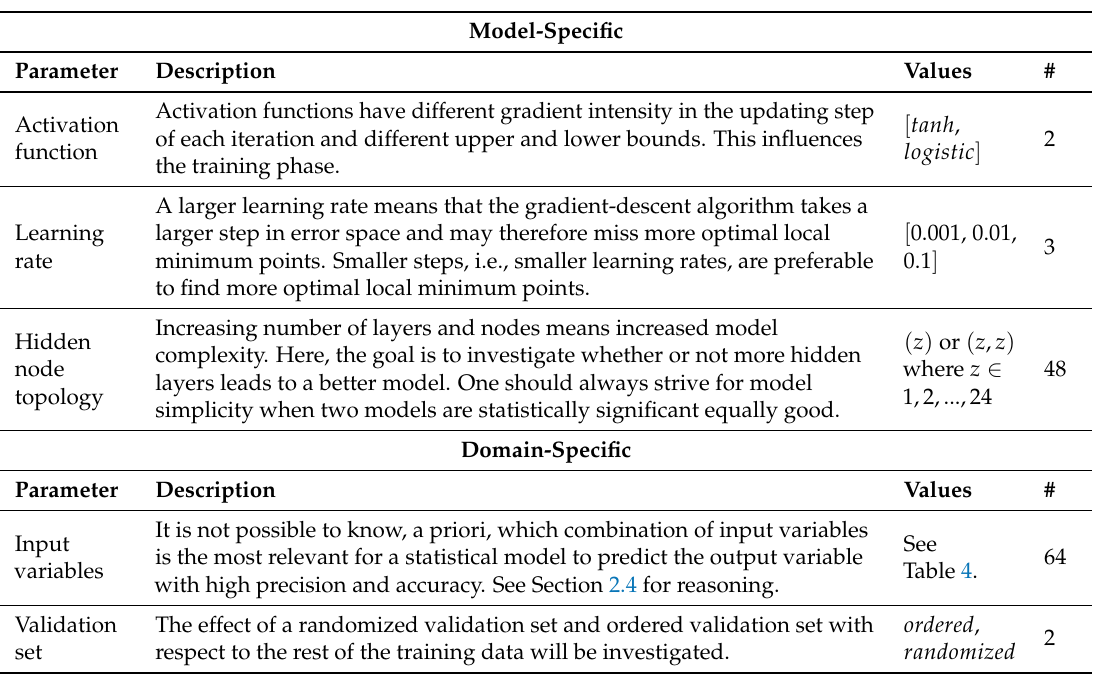
Table 7. The parameters used in the grid-search of which 2 · 3 · 48 = 288 are model-specific and 64 · 2 = 128 are domain-specific. A total of 288 · 128 = 36,864 parameter combinations.